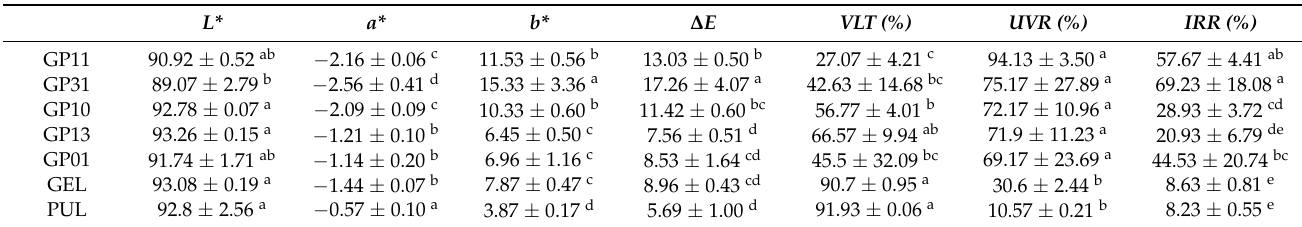
Figure 6. Images of film samples. Table 3. Color parameters and optical properties of different